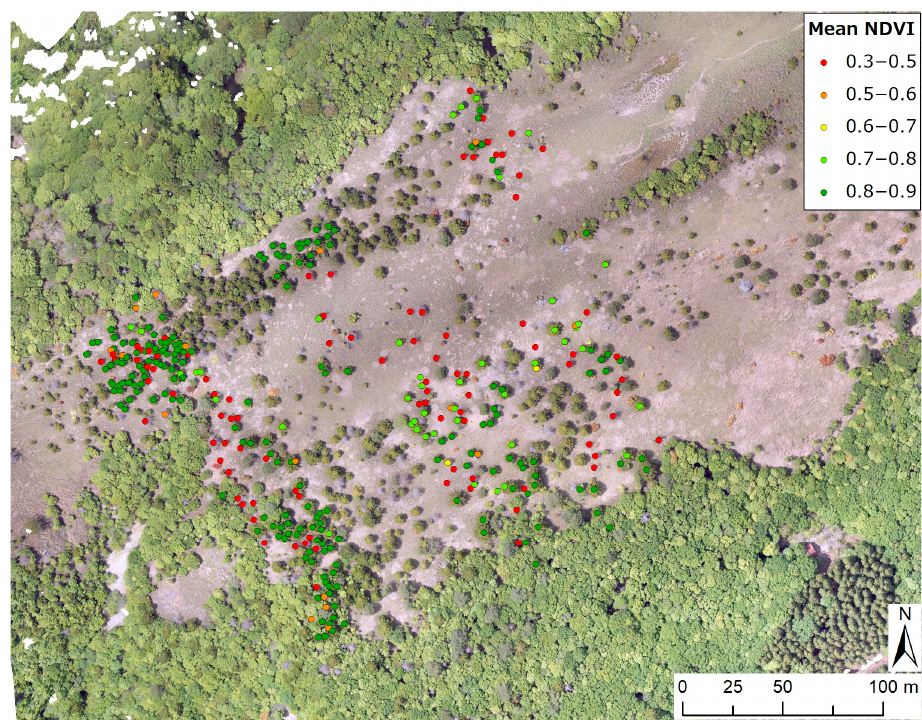
Figure 6. Mean value of NDVI within the canopy polygon of the tree-by-tree survey.